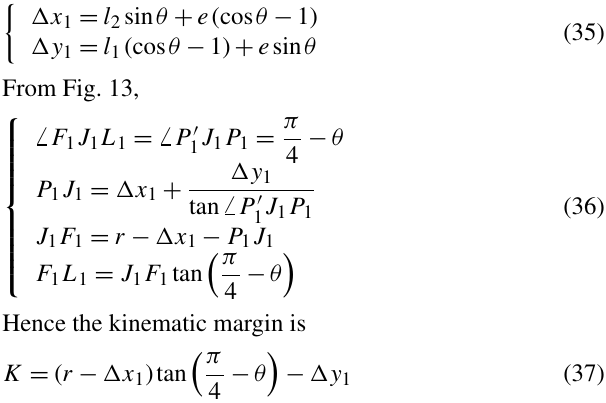
Figure 17. Displacements varying with time of MetaRobot I with trunk twisting (the red solid line) and the quadruped with a single rigid body (the blue dash